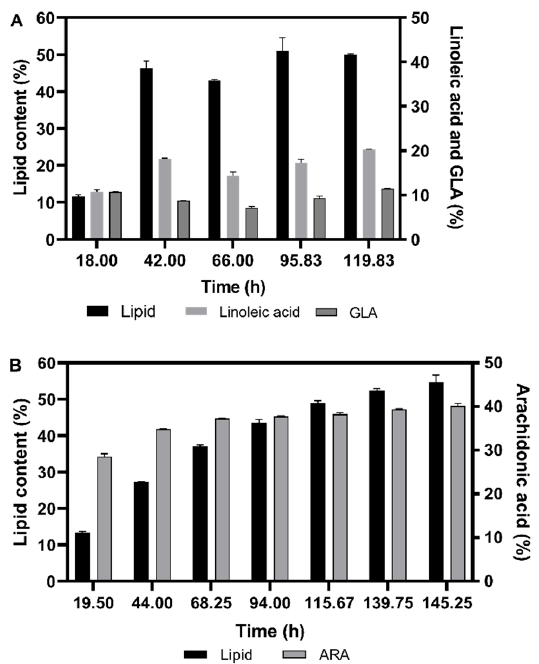
Figure 2. ( A ) Total lipid content (% wt of dry cell weight), linoleic acid, and GLA (% wt of total lipid weight) for M. circinelloides , and ( B ) total lipid content (% wt of dry cell weight) and arachidonic acid (ARA) content (% wt of total lipid weight) for M. alpina , grown on glucose in shake